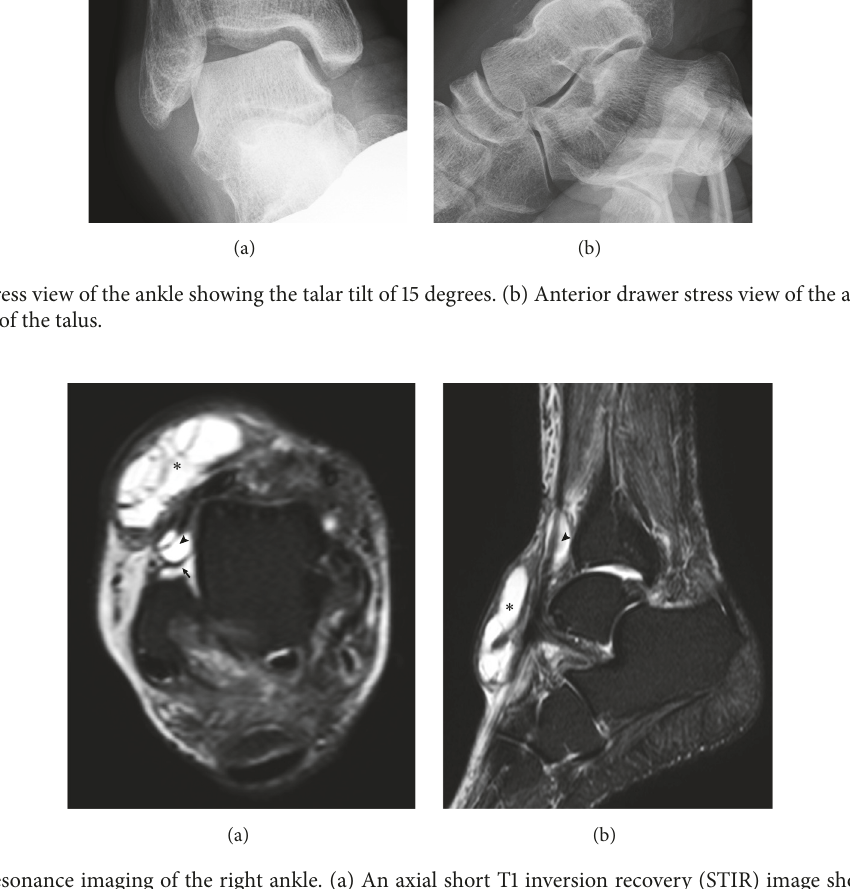
Figure 3: Magnetic resonance imaging of the right ankle. (a) An axial short T1 inversion recovery (STIR) image showing fluid collection in the lateral premalleolar bursa (asterisk). Fluid collection may also be seen in the tendon sheath of the extensor digitorum longus (EDL) (arrowhead). The anterior talofibular ligament is unstrained (arrow). (b) A sagittal STIR image showing fluid collection in the tendon sheath of the EDL just anterior to the ankle